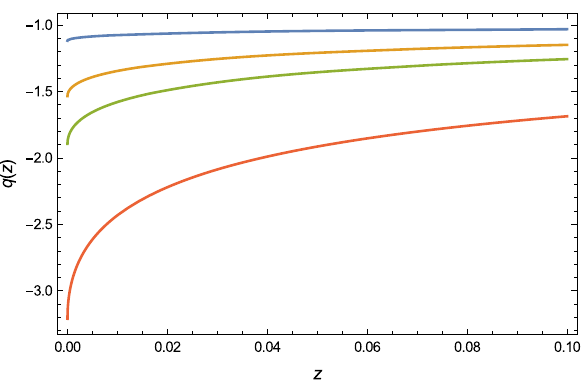
Fig. 7 Evolution of deceleration parameter with respect to redshift. The various colors take on the following values of the index n . Red n = − 0 . 5, green n = 1 . 5, yellow n = 3, blue n =